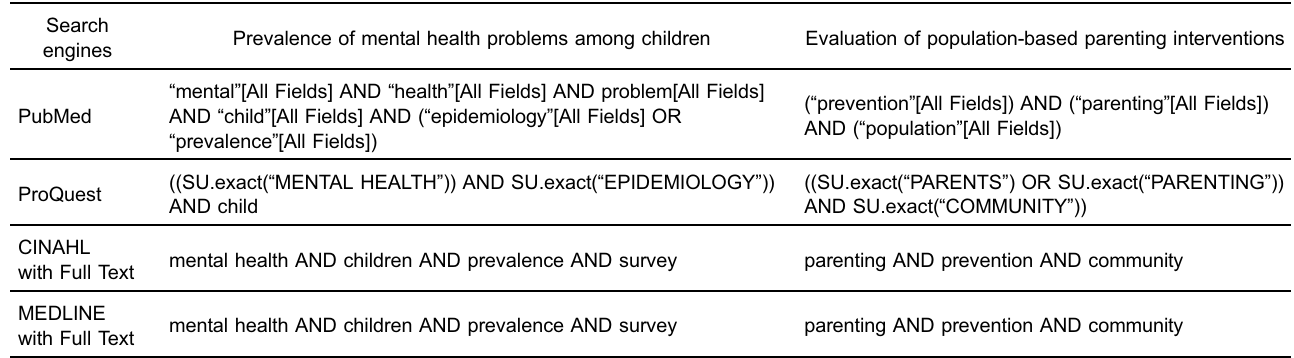
Table 1. Search strategies Search Prevalence of mental health problems among children Evaluation of population-based parenting engines